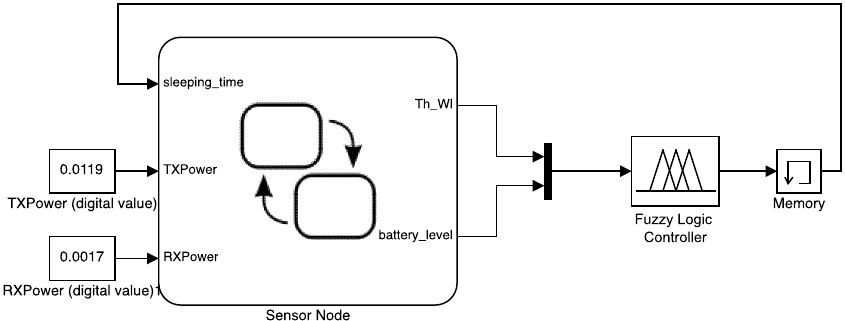
Figure 5. Simulation model developed in